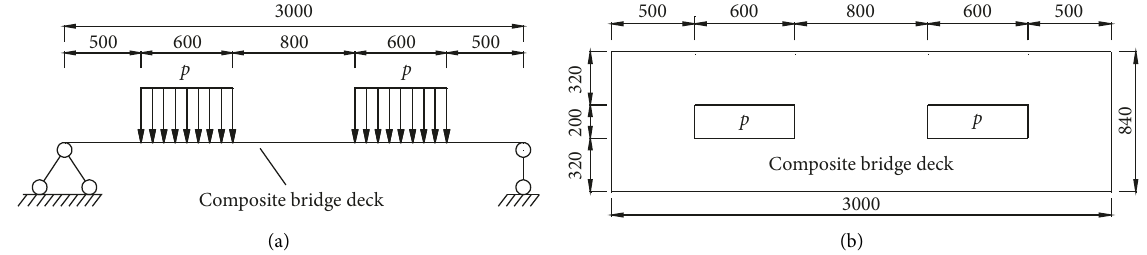
Figure 11: Load placement. (a) Longitudinal position. (b) Plane position.